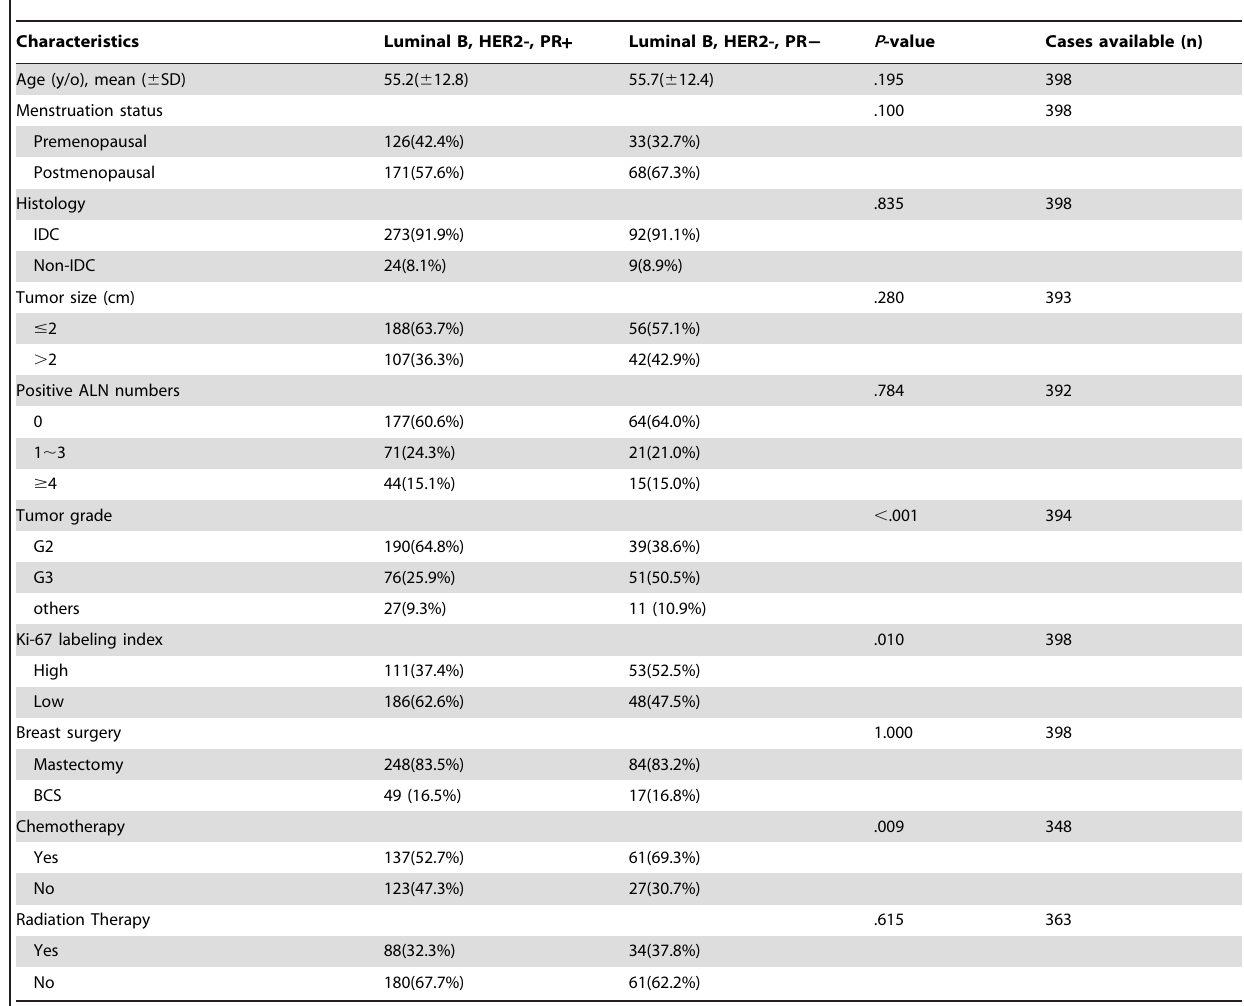
Table 1. Association of patient and tumor characteristics with PR